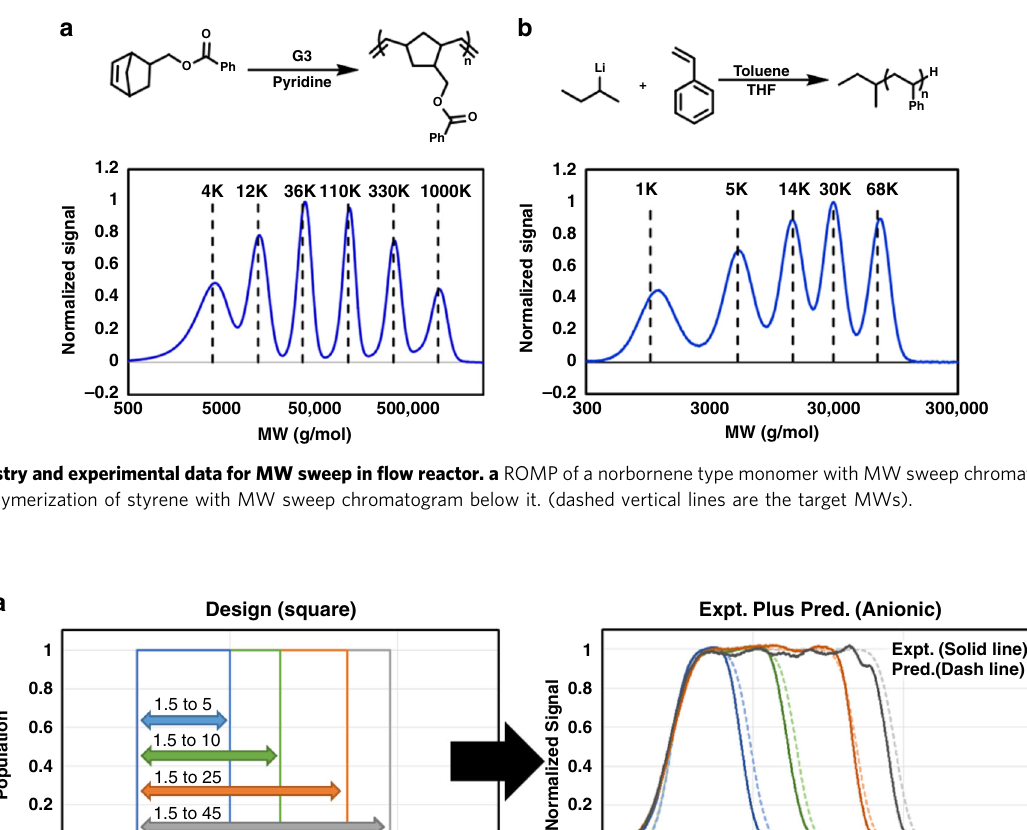
Table 1 Data for the synthesis of square MWD by anionic polymerization of styrene.